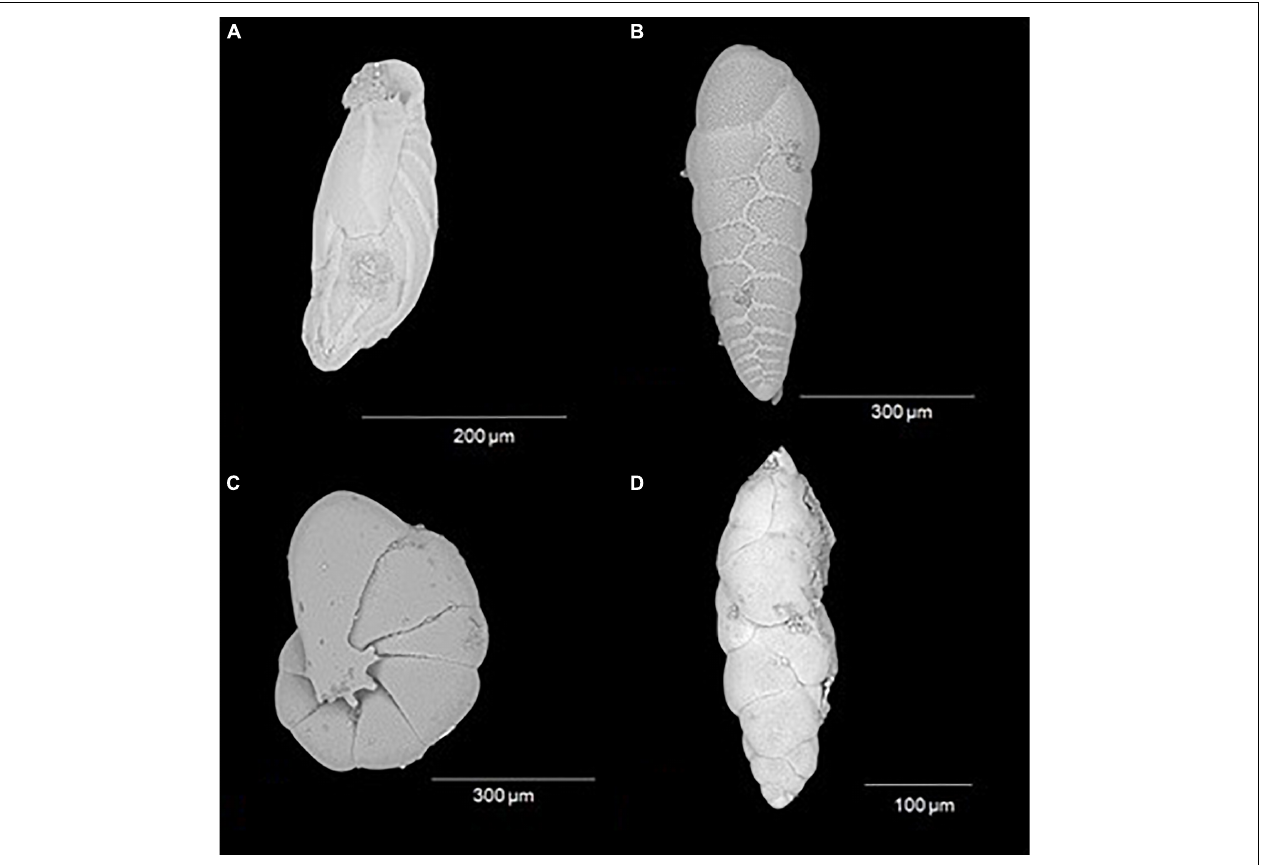
FIGURE 5 | Most abundant benthic foraminifera species on a spatial and vertical distribution. (A) Buliminella elegantissima ; (B) Bolivina seminuda ; (C) Nonionella stella ; and (D) Fursenkoina sp.